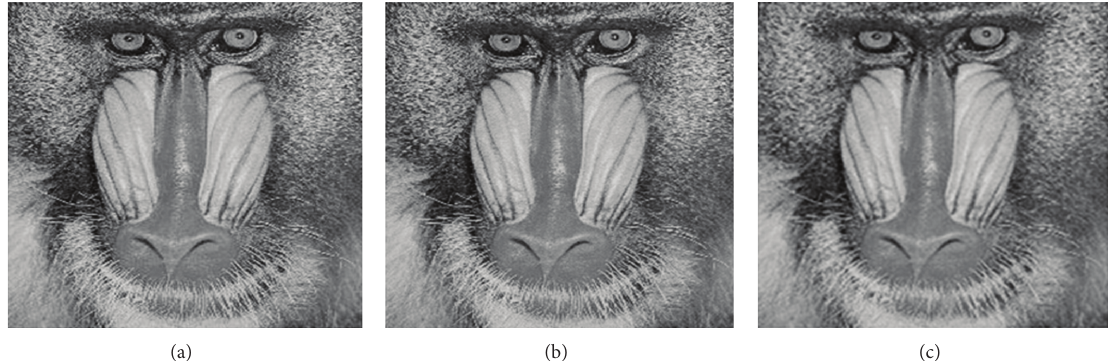
Figure 4: (a) cover image, baboon. (b) Stegoimage with 𝐻𝐻1 embedding. (c) Stegoimage with 𝐿𝐻1 , 𝐻𝐿1 , and 𝐻𝐻1 subband.